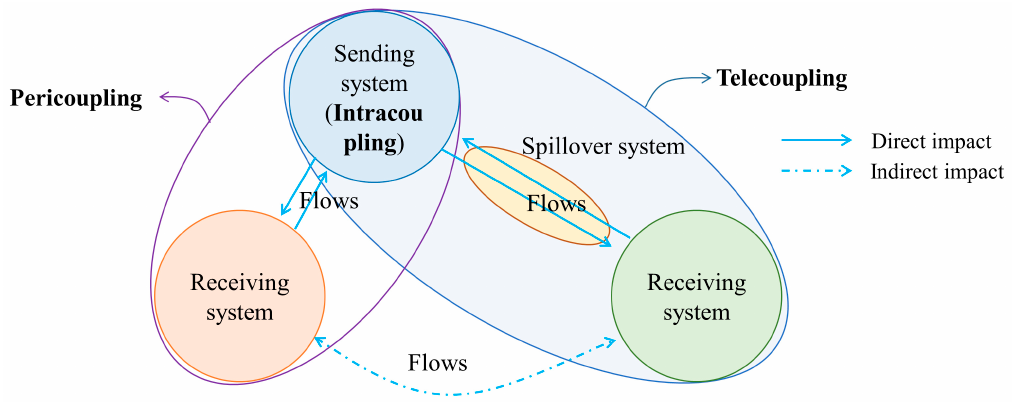
Figure 2. Metacoupling